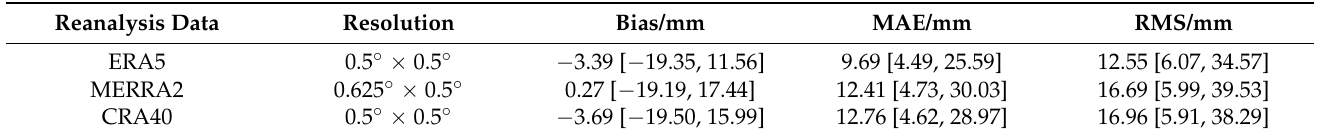
Figure 7. ZTD bias, MAE, and RMS distribution from ERA5 ( a – c ), MERRA2 ( d – f ), and CRA40 ( g – i ). Table 4. Statistical results of three inverted ZTD errors (Brackets indicate the error range).